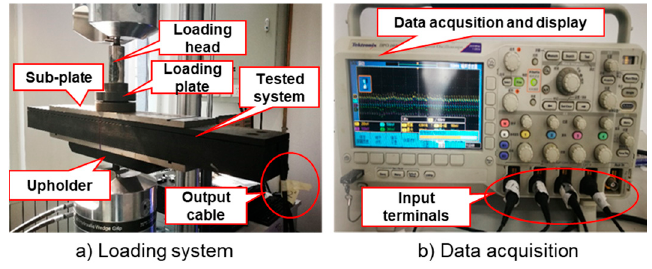
Figure 8. Indoor test process.